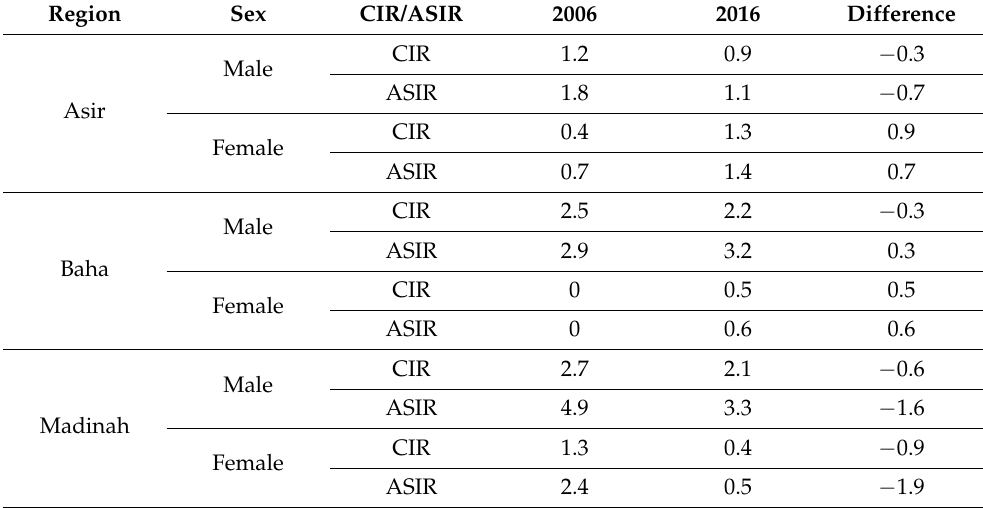
Table 2. The difference in CIR and ASIR between 2006 and